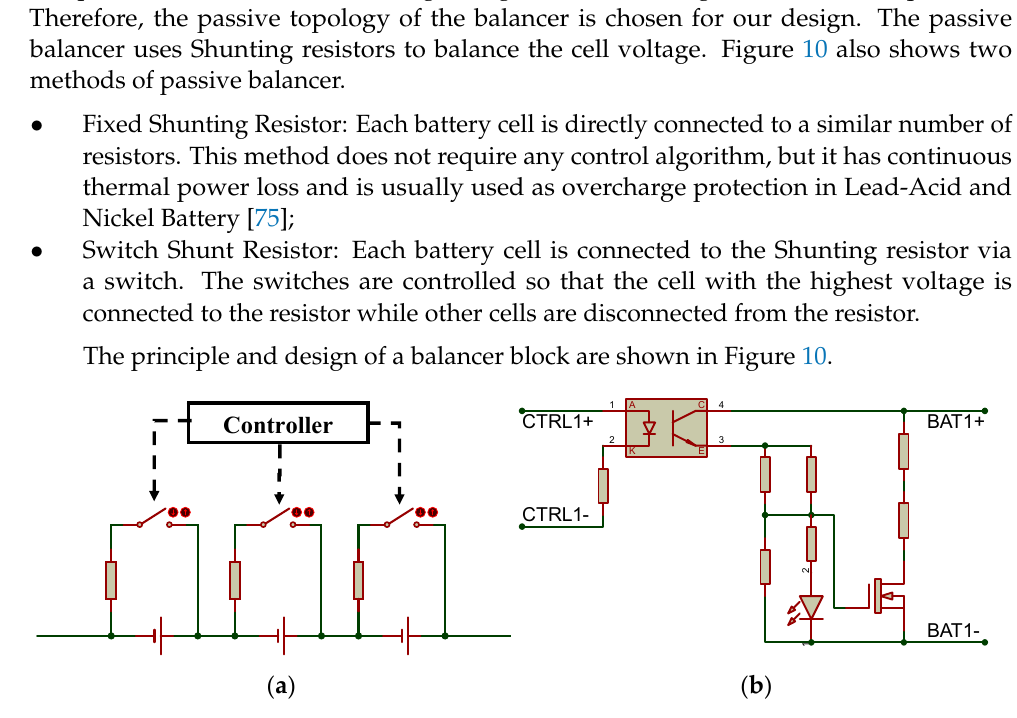
Figure 10. Balancer block: ( a ) Basic principle; ( b ) Design of balancer circuit for one cell.